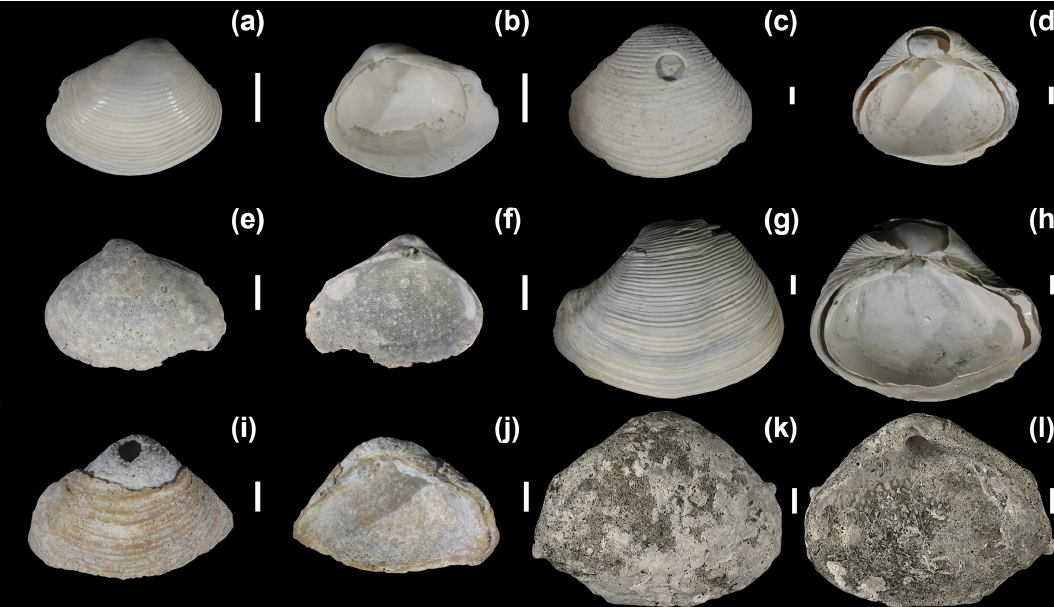
Figure 6. Varicorbula gibba from Piran and Brijuni (sites with slow sedimentation rates) with worn, bored, encrusted, and stained valves. (a– bar: 1mm.